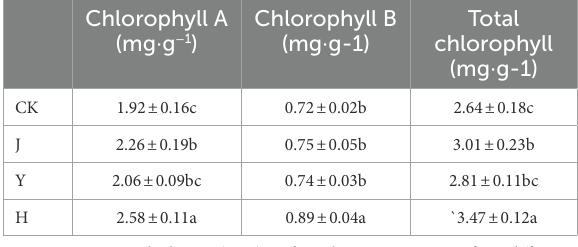
TABLE 6 Comparison of Chlorophyll Content of soybean leaf after treatment with various bacterial inoculants. Chlorophyll A (mg·g − 1